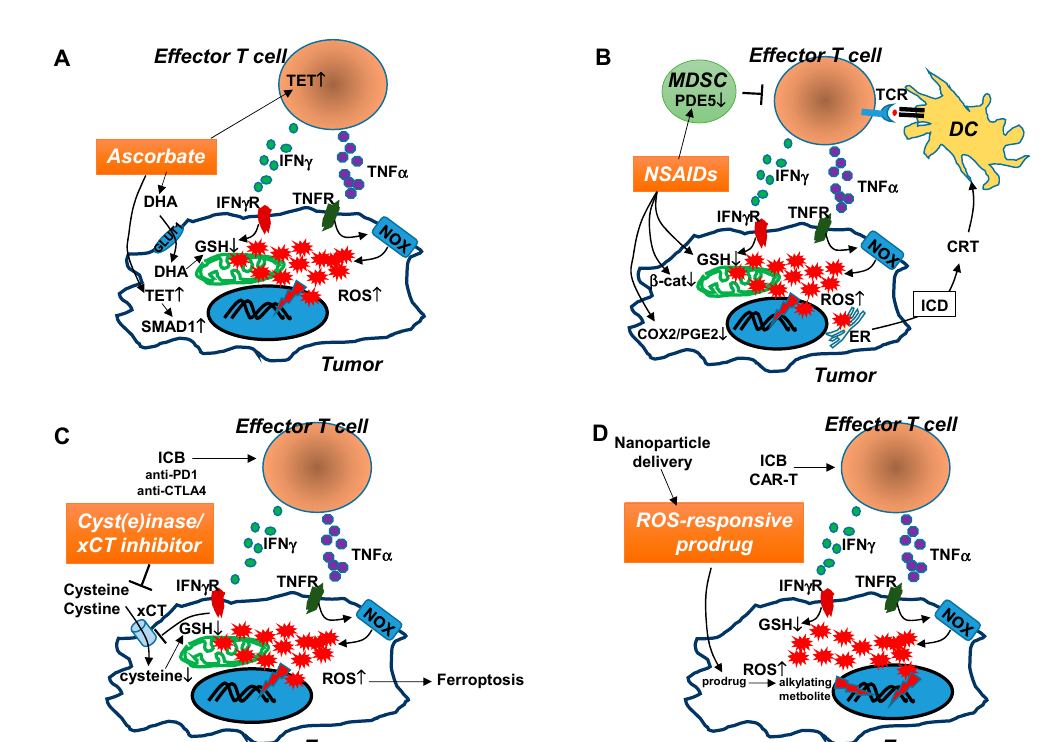
Figure 2. Hypothetical mechanisms by which certain pro-oxidants enhance the efficacy of cancer immunotherapies. Tumor-reactive effector T cells, emerging in the TME after either ICB therapy or adoptive transfer, can mediate tumor killing via well-characterized mechanisms involving cytolytic granules such as perforin and granzymes, and apoptosis-inducing ligands such as FASL and TRAIL. Increasing evidence reveals that inflammatory cytokines produced by effector T cells, including TNF α and IFN γ , can exert antitumor effect by modulating tumor redox. TNF α signaling in cancer cells activates NOX-dependent ROS production, while IFN γ signaling exacerbates GSH deficiency by suppressing the cysteine/glutamate transporter xCT. The combined effects of TNF α and IFN γ lead to substantial ROS accumulation in tumor cells, rendering them vulnerable to further redox disruption which can be incited by a pro-oxidant. A suitable pro-oxidant should preferentially induce oxidative stress in cancer cells without harming antitumor T cells. The potential mechanisms of action of four immunotherapy-compatible pro-oxidants are illustrated. ( A ). Pharmacological dose of ascorbate, in its oxidized form DHA, can be preferentially taken into cancer cells via the glucose transporter (GLUT1). Intracellular DHA is reduced to ascorbate at the expense of GSH. The GSH shortage aggravates ROS accumulation, which damages DNA/protein/lipid and derails cell metabolism, leading to tumor cell death. Meanwhile, ascorbate may induce TET activities in antitumor T cells and tumor cells. TET activation in T cells leads to enhanced function of T cells through epigenetic modifications. TET activation in tumor cells results in demethylation and activation of SMAD1, which increases tumor chemosensitivity. ( B ). NSAIDs can act as pro-oxidants to reduce GSH and thereby increase the levels of ROS in tumor cells. NSAID-induced ER stress may lead to release of calreticulin (CRT), a DAMP molecule characteristic of ICD, which can attract and activate DCs, which in turn elicit antitumor CD8+ T cell responses. In addition, NSAIDs can suppress tumor cell growth by its inhibitory effect on β -catenin, COX2, and PGE2. Some NSAIDs may reduce MDSC activity by inhibiting PDE5 function in MDSCs. ( C ). Cyst(e)inase or xCT inhibitors can reduce the presence or block the uptake of extracellular cystine and cysteine, which tumor cells rely on to synthesize GSH, respectively. Cyst(e)inase can act in concert with ICB-induced antitumor T cells to drive tumor cell ferroptosis. ( D ). ROS-responsive prodrugs can be effectively delivered to tumor loci by nanoparticles. The increased levels of ROS in the TME can activate these prodrugs, which give rise to alkylating metabolites to cause further DNA damage and intensify oxidative stress in tumor cells. These prodrugs may synergize with antitumor T cells because ROS accumulated in tumor cells after immunotherapies such as ICB or CAR-T therapy can effectively activate prodrugs, which in turn further amplify ROS in tumor cells to drive apoptosis.